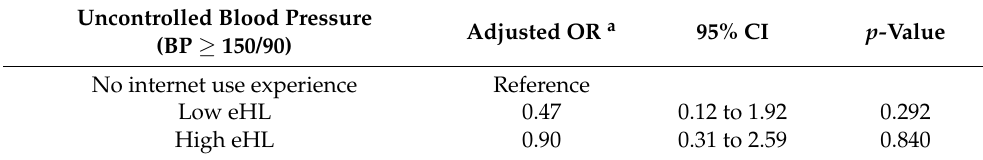
Table 5. Association between electronic health literacy and uncontrolled blood pressure ( n =